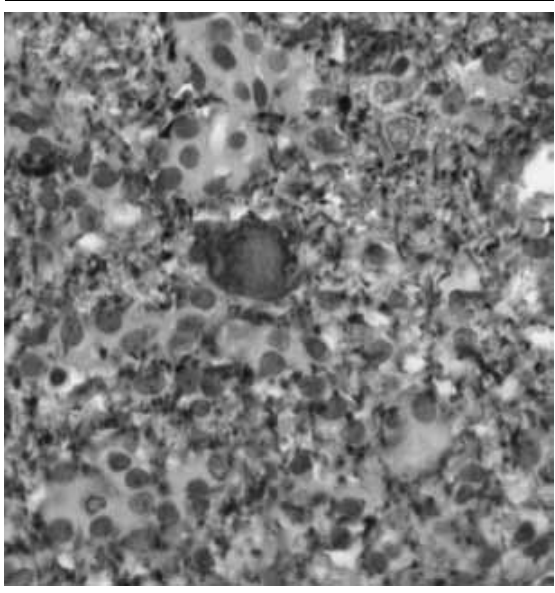
figurE 6 – Eosinophilic granular body immunostained with NF in ganglioglioma in the center of the image (lens 40×) NF: